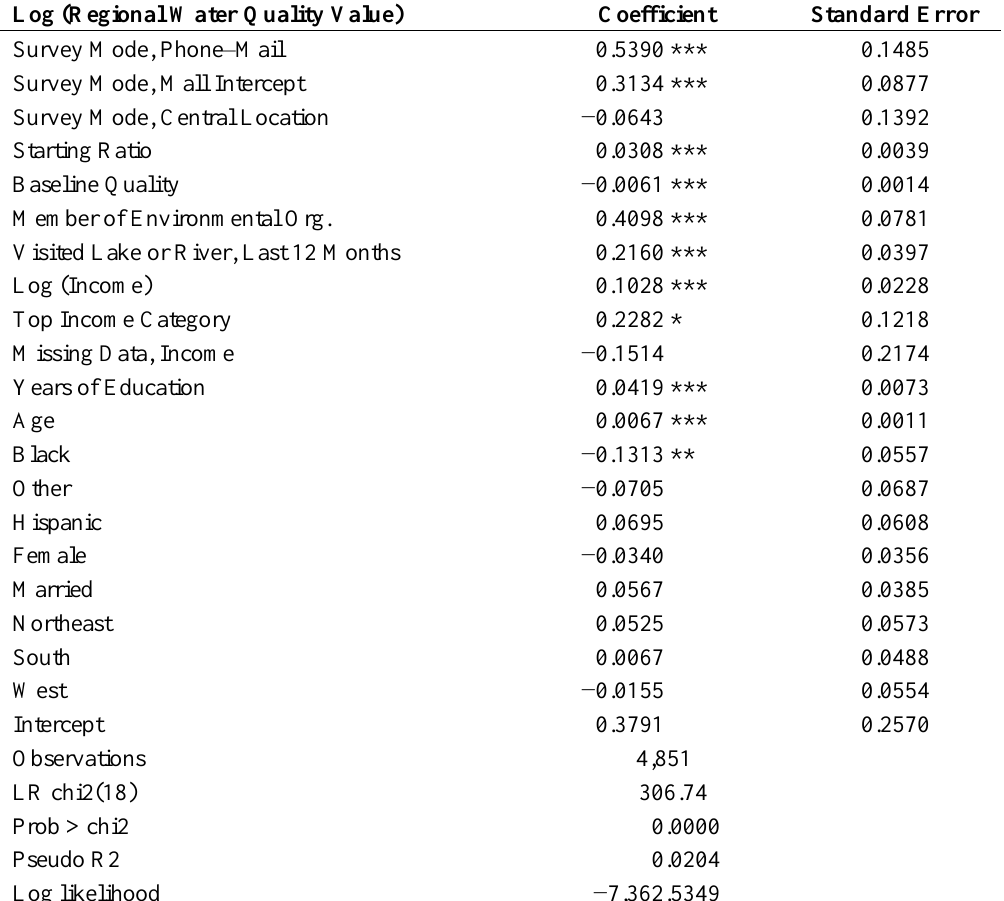
Table 3. Censored-normal regression of log of regional water quality value a